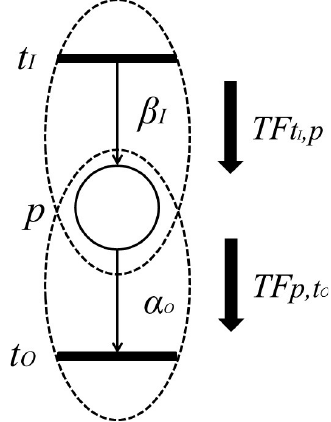
Figure 6. Input and output token